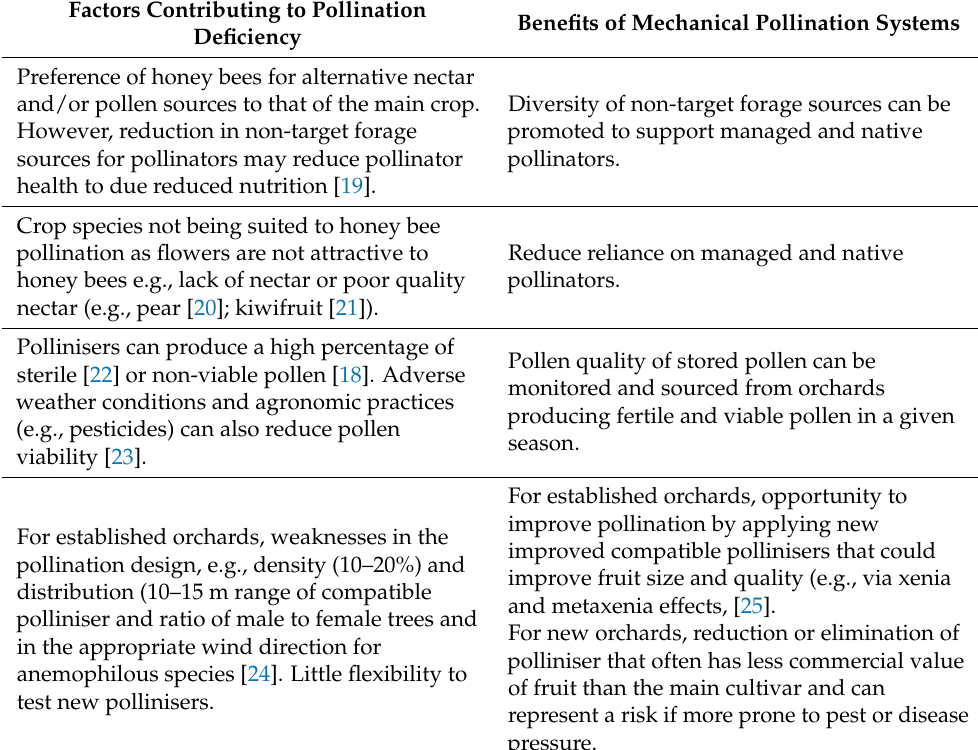
Table 1. Cont. Factors Contributing to Pollination Benefits of Mechanical Pollination Systems Deficiency Preference of honey bees for alternative nectar and/or pollen sources to that of the main